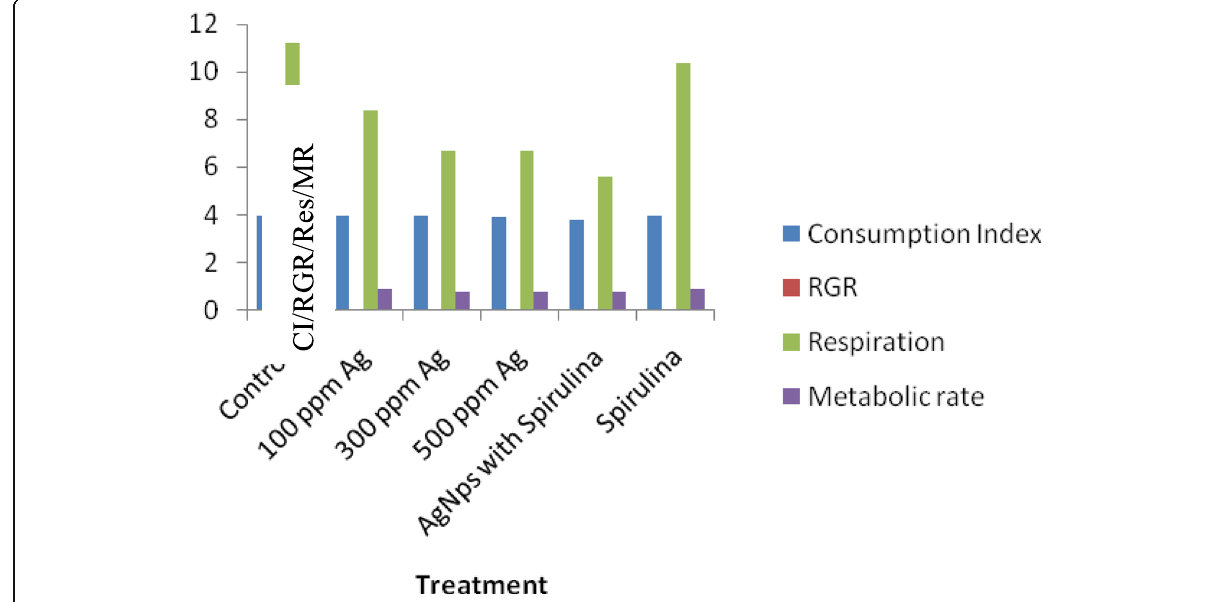
Fig. 4 Comparison of consumption Index, relative growth rate, respiration, and metabolic rate of treated silkworm